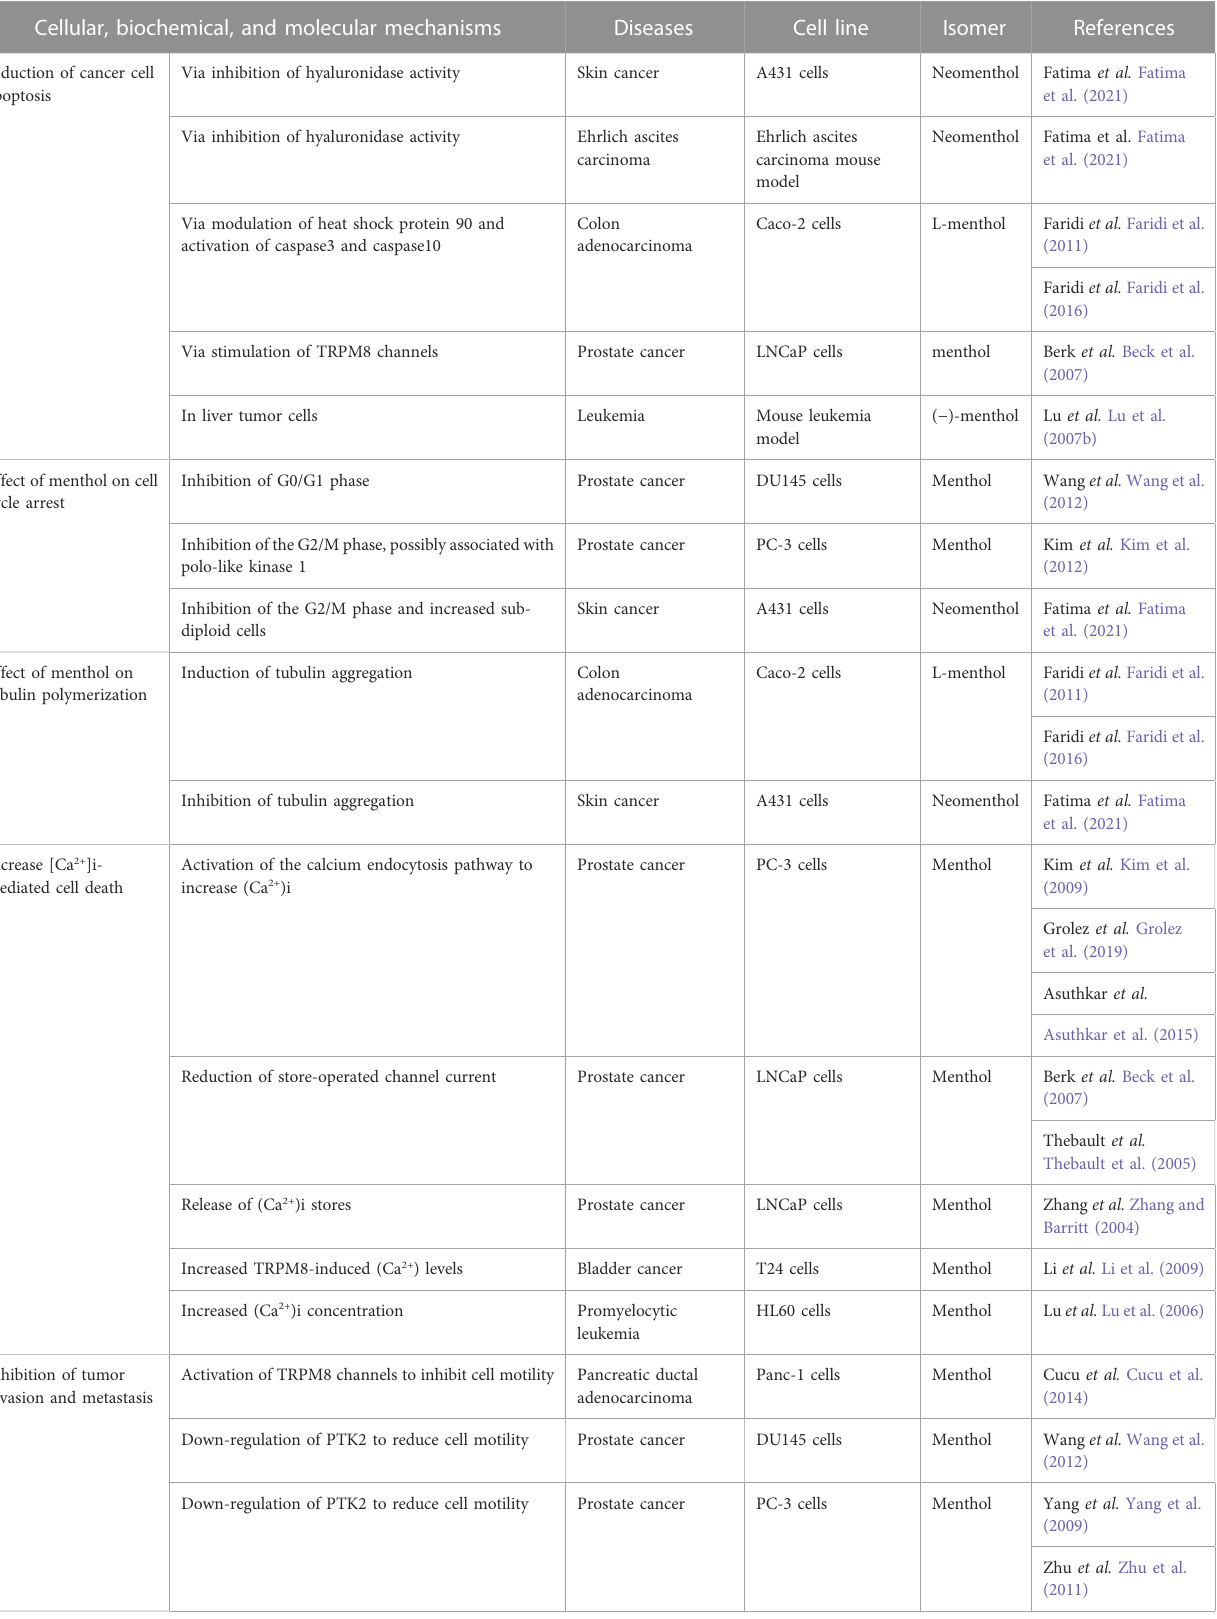
TABLE 1 Mechanisms underlying the anticancer activity of menthol. Cellular, biochemical, and molecular